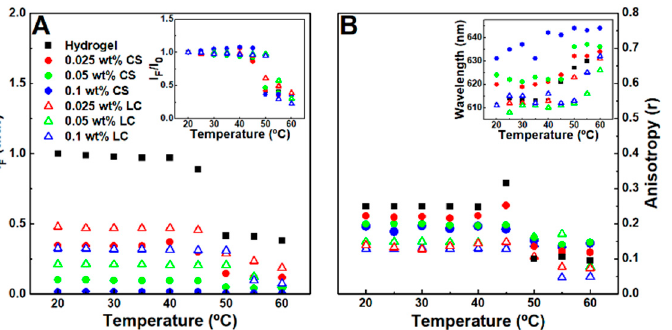
Figure 4. ( A ) Nile Red (2 µM) maximum fluorescence emission dependence on the temperature of hydrogel, citrate-stabilized (CS), and lipid-coated (LC) nanoparticles containing magnetogels. Inset: Normalized maximum fluorescence emission dependence on the temperature of the respective gels. ( B ) Nile Red fluorescence anisotropy dependence on temperature. Inset: Nile Red maximum emission wavelength dependence on temperature.